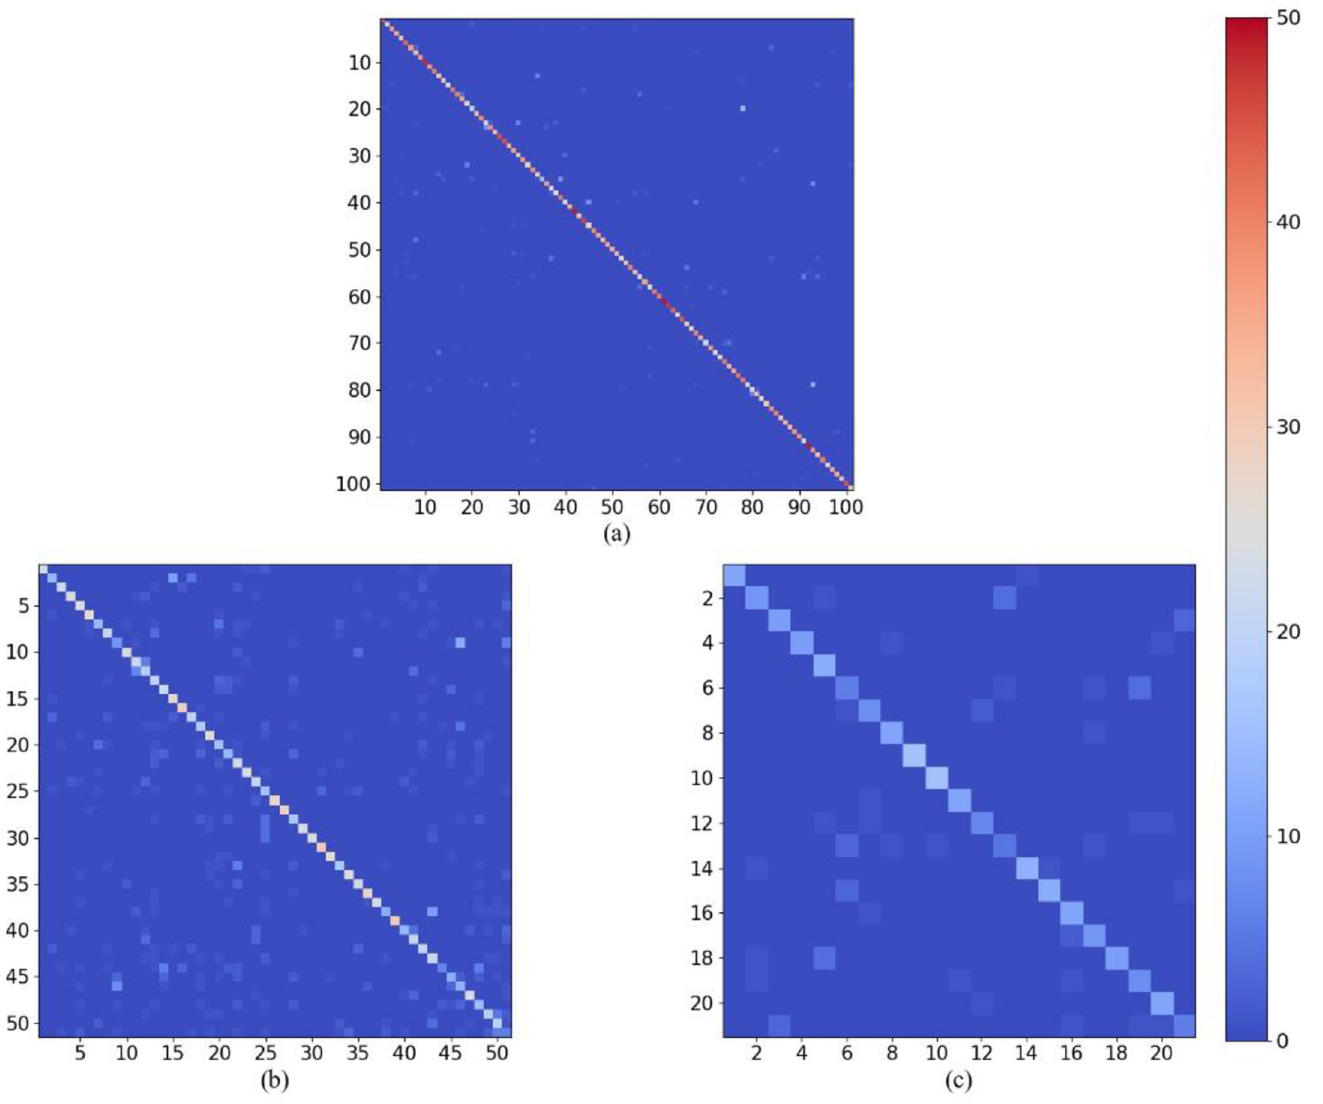
Fig 5. Confusion matrices for the three datasets using our STA-TSN. (a) UCF101 dataset, (b) HMDB51 dataset, and (c) JHMDB dataset. Horizontal axis represents predicted class, the vertical axis represents actual class and the main diagonal represents the true positives. The main diagonal is brighter, the number of the true positives is